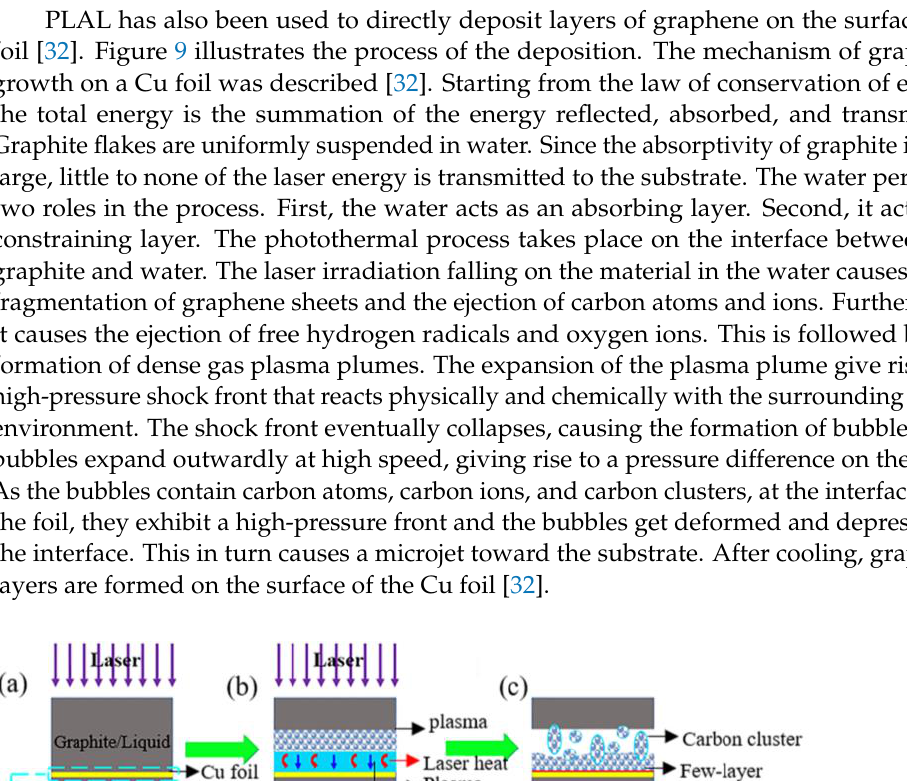
Figure 8. Graphene formation mechanism (Created with BioRender.com).